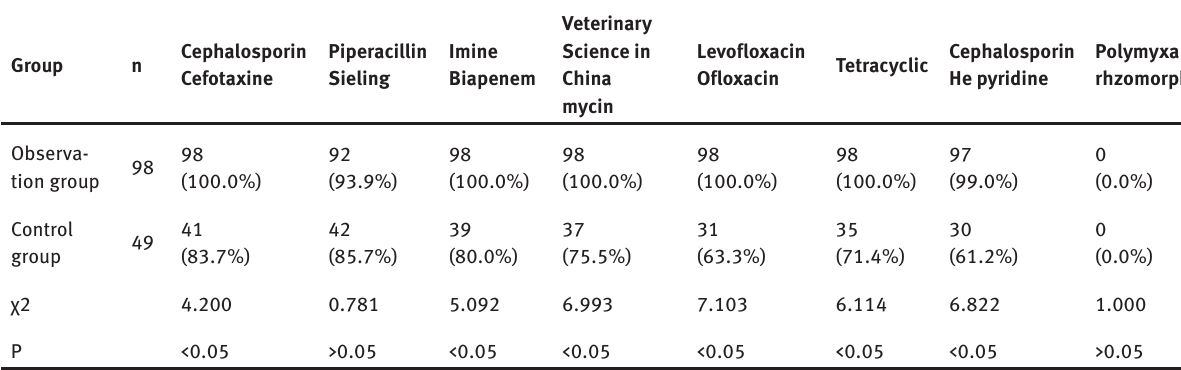
Table 1: Two groups of different antimicrobial resistance analysis (n)